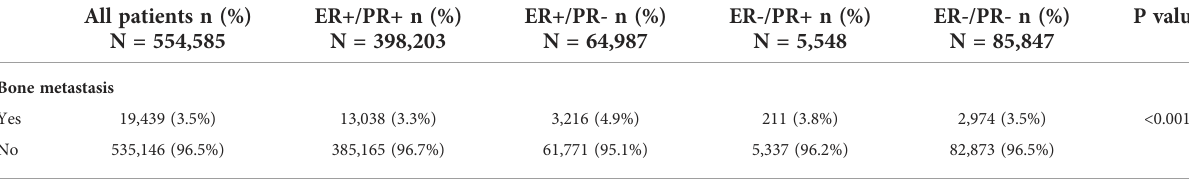
TABLE 1 Bone metastasis incidence in breast cancer patients strati fi ed by hormone receptor status. All patients n